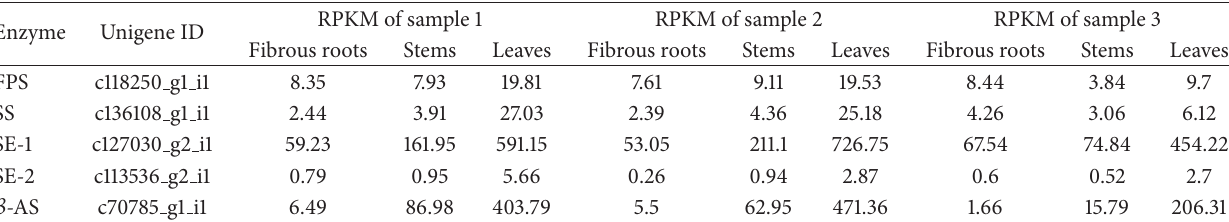
Table 3: RPKM of unigenes (FPS, SS, SE, and 𝛽 -AS) in samples.